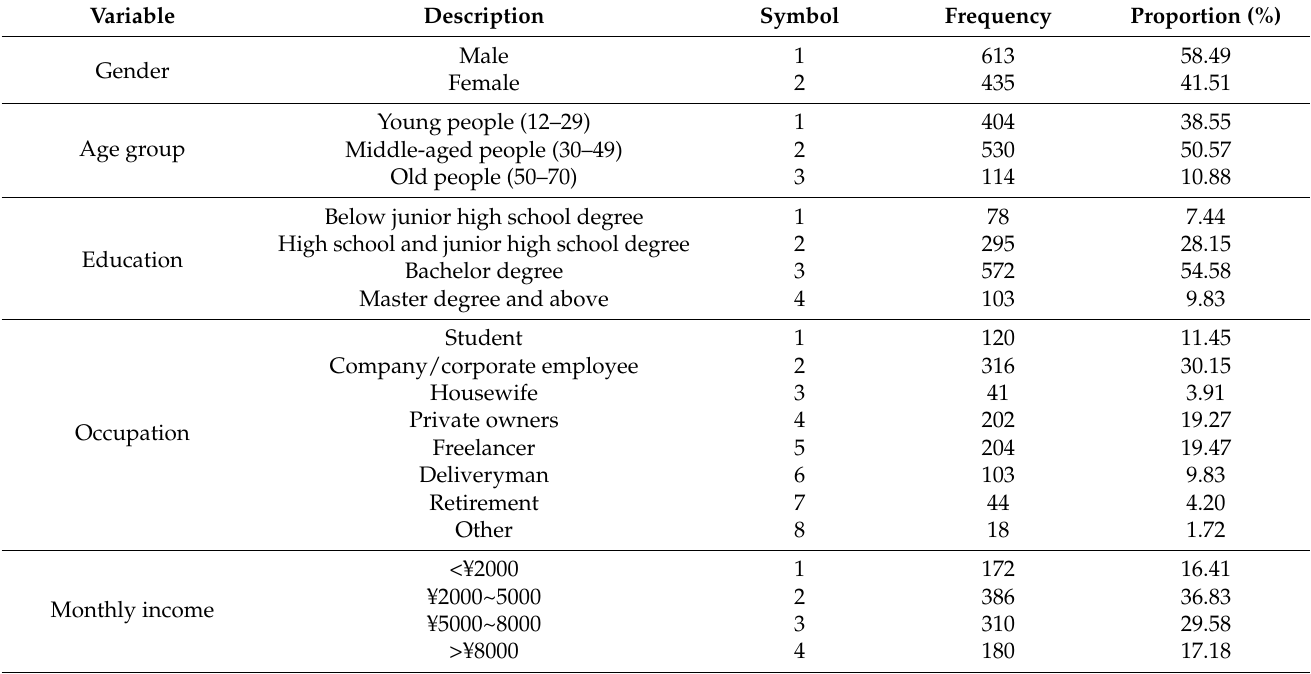
Table 1. Descriptive statistics for demographic information.